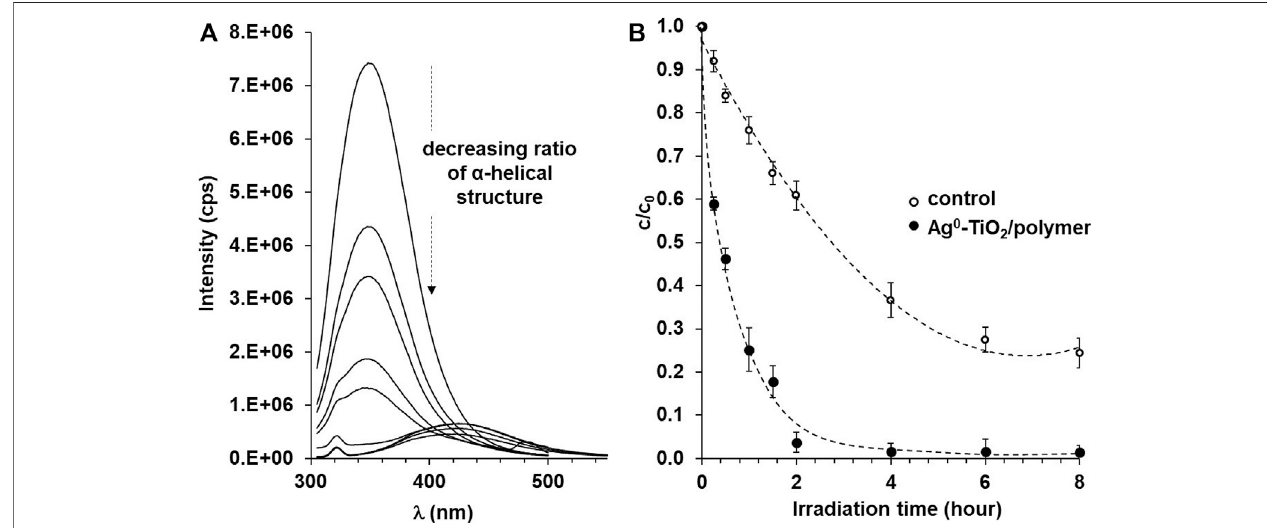
FIGURE 5 | The decreasing fl uorescence spectra of the BSA test protein (A) and the photocatalytic degradation rate of BSA (B) on Ag 0 -TiO 2 /polymer nanohybrid thin fi lms as a function of irradiation time under visible-light illumination.